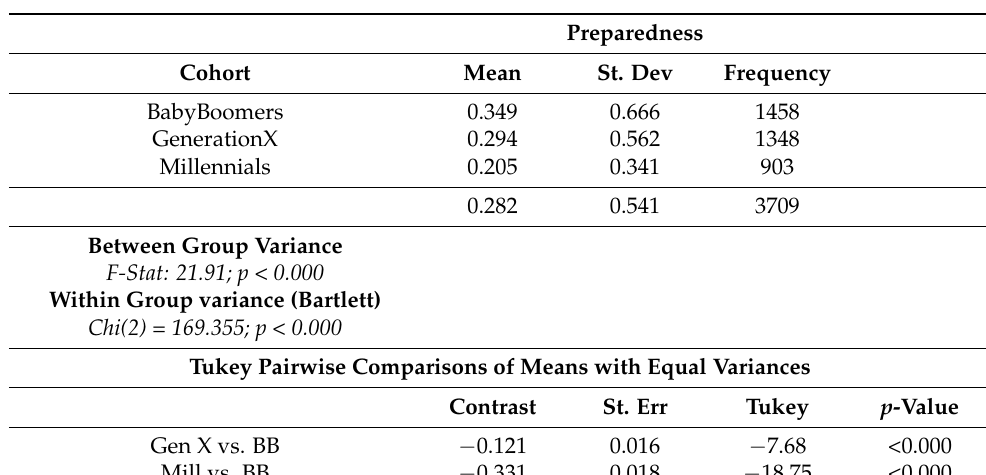
Table A4. ANOVA of Retirement Preparedness by Generational Cohorts.